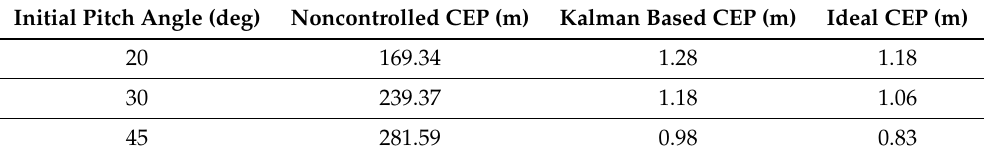
Table 7. The CEP for noncontrolled flights, Kalman hybridization based controlled flights and ideally controlled flights for 20 ◦ , 30 ◦ and 45 ◦ initial pitch